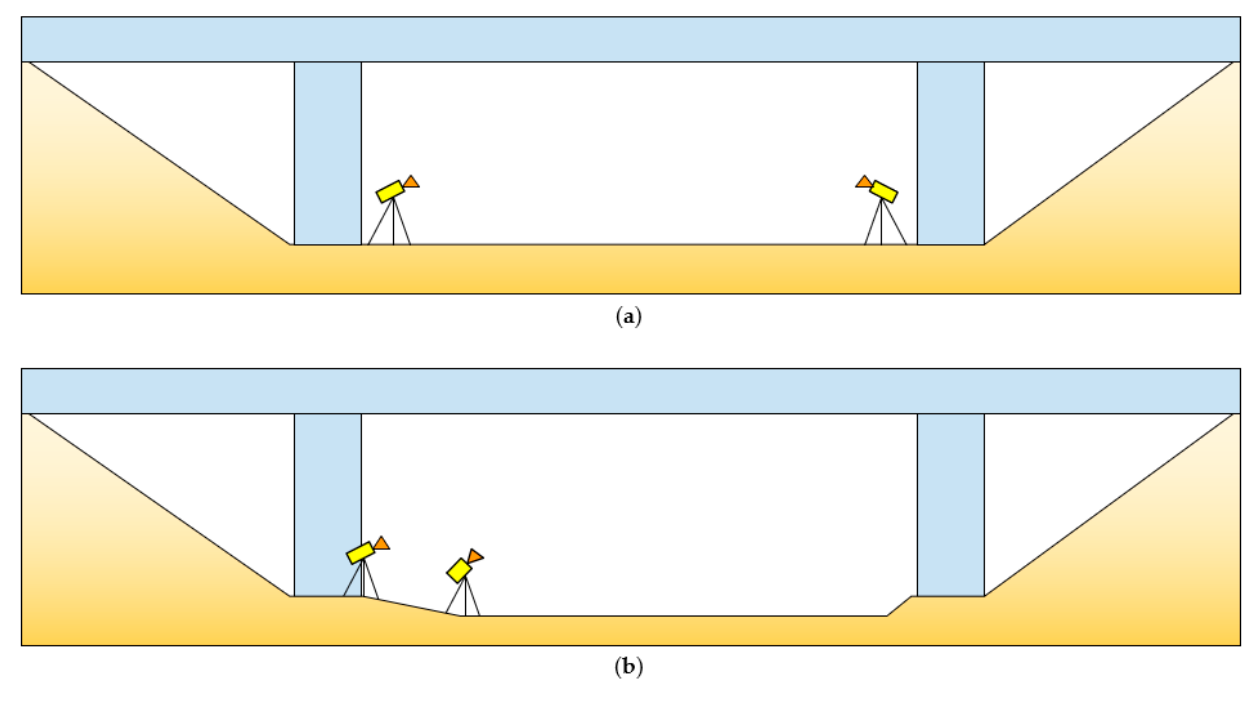
Figure 3. Two basic configurations of the position of the two radars when measuring bridges: ( a ) the radars measure against each other—at the top, or ( b ) the radars measure from one side (radars are placed behind each other)—at the bottom.